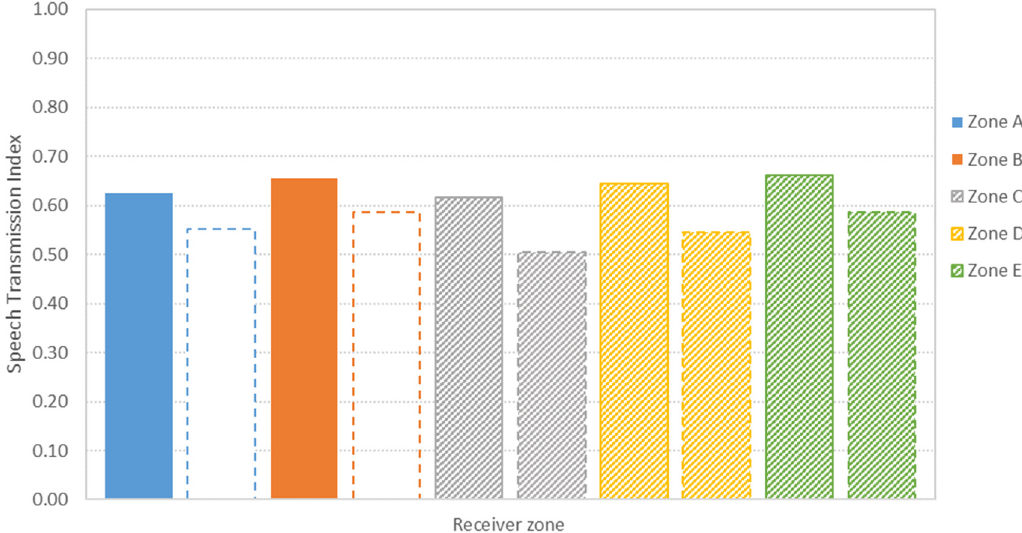
Figure 12. Speech transmission index (STI) obtained in the auditorium, when the variable acoustic solution provides maximum absorption (solid columns—configuration A) and when the variable acoustic solution provides maximum reflection (dashed columns—configuration R), by zones.